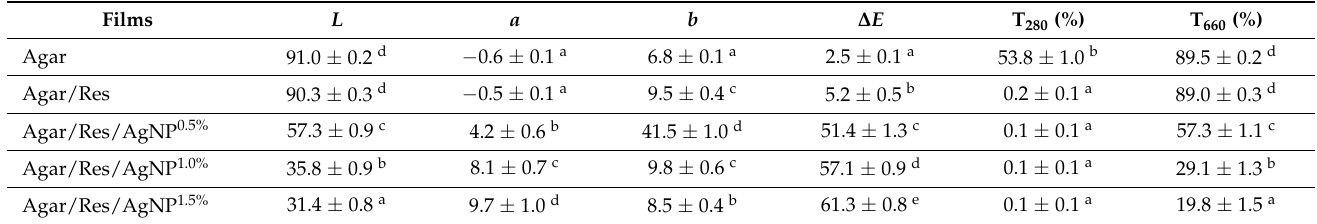
Table 1. Surface color and light transmittance of the agar-based composite